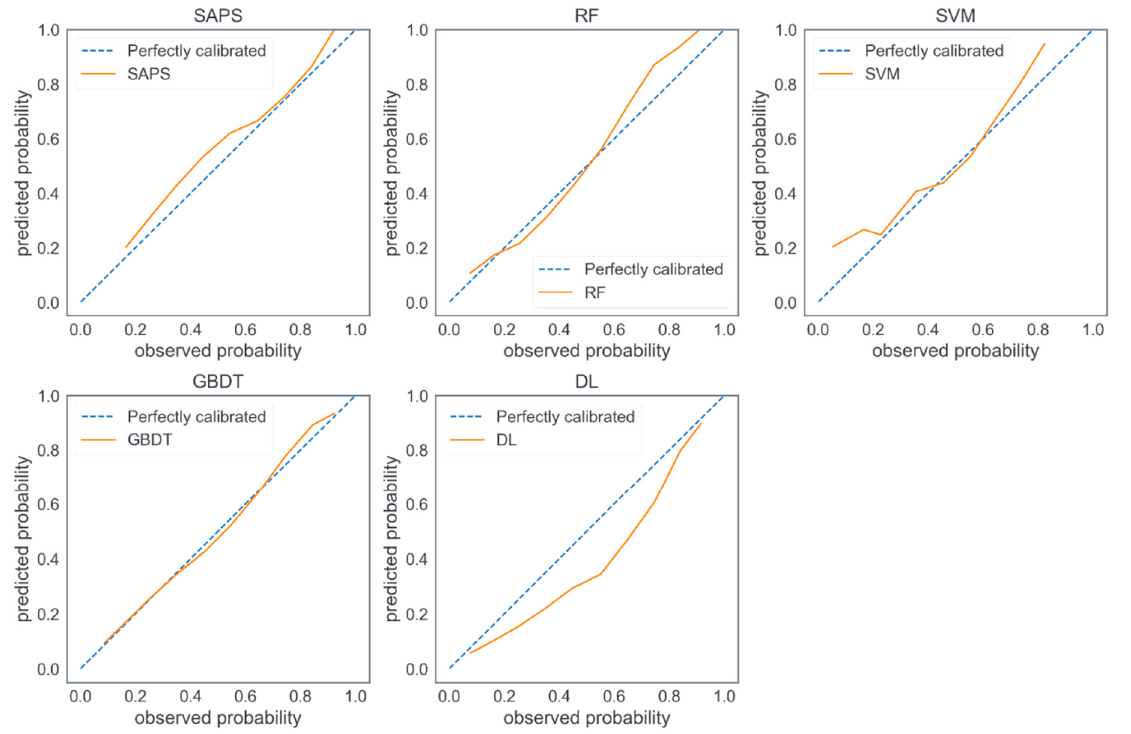
Figure 2. Calibration plots of the five models on MIMIC-III.